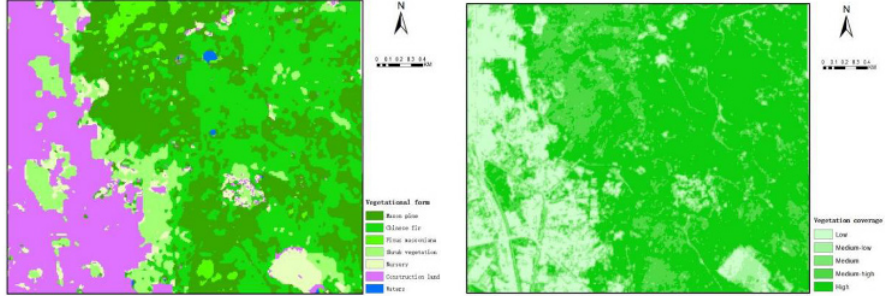
Fig. 3. Vegetation type factor level. Fig. 4. Vegetation cover factor